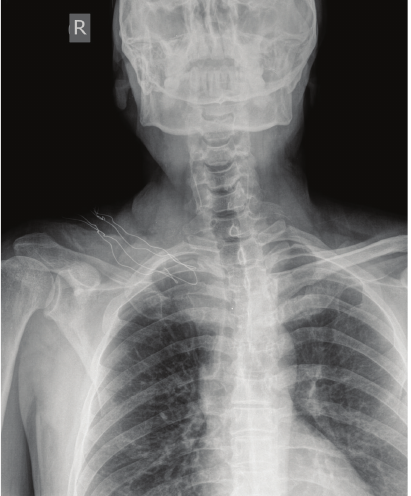
F 4: Anteroposterior roentgenography aer removal of right